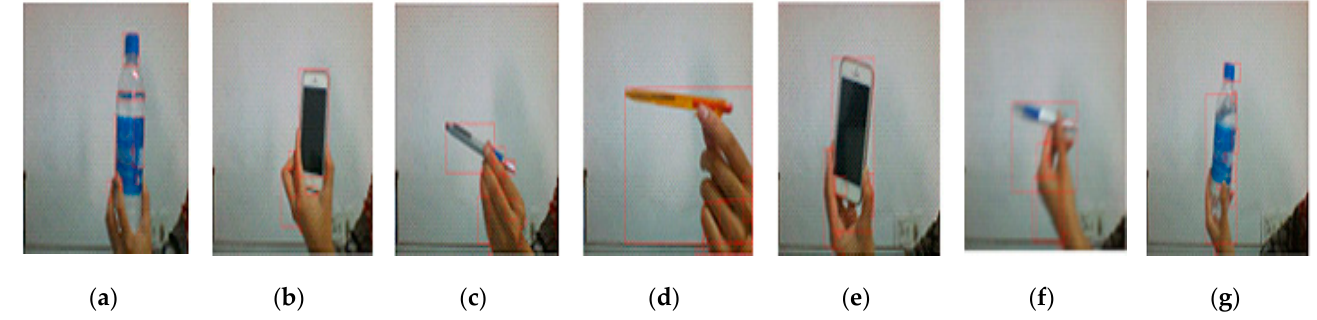
Figure 3. Scenario performance of PSA for both bottom-up cycle and top-down cycle. This figure defines the recognition of different objects through PSA bottom-up and top-down attention processes. ( a ) Define the bottle object with significant bright color detection. ( b ) Is the recognition of moving cell phone with orientation change, which can miss the actual recognition of object. ( c ) Define a pen with orientation change, ( d ) show the pen in moving condition. ( e ) Shows the cell phone in straight condition for clear vision of object. ( f , g ) shows pen and bottle respectively with fast moving rate to find the performance of agent for fast object recognition.